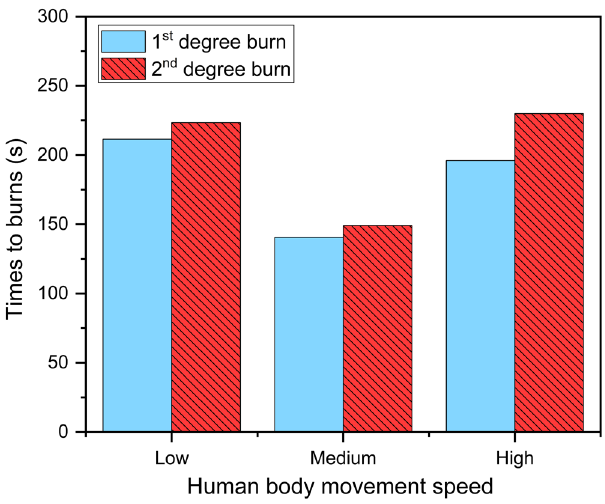
Figure 14. Effect of the human body movement speed on skin burns.